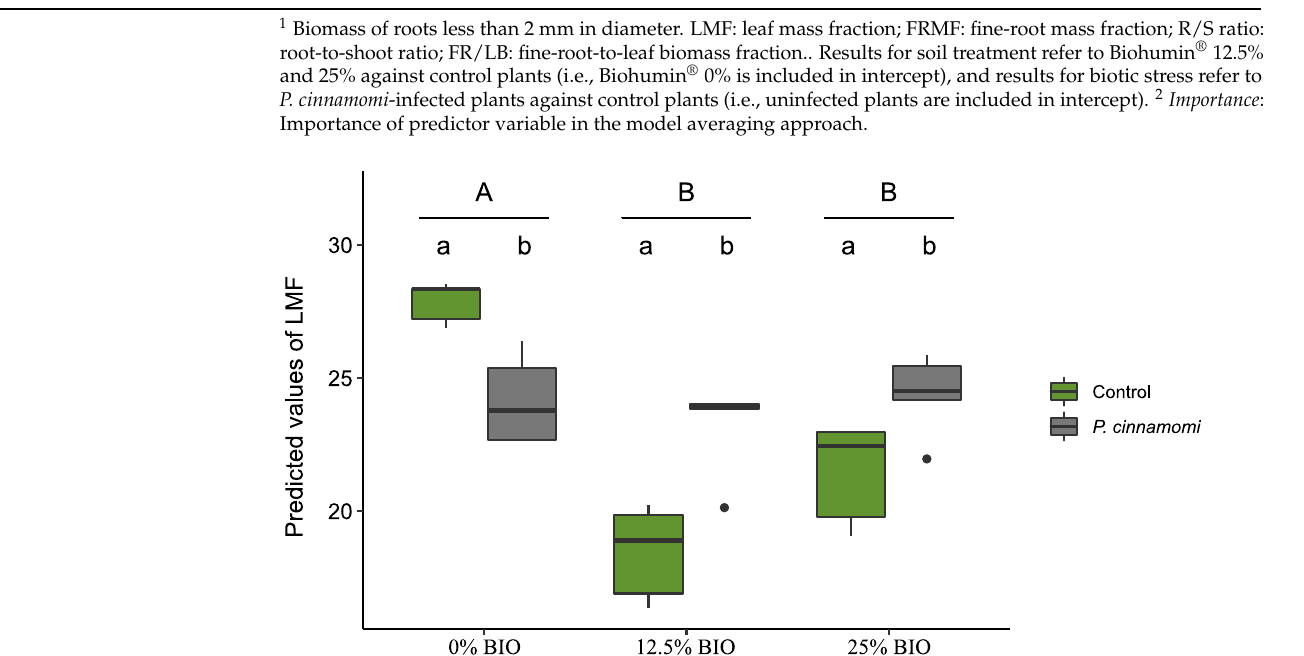
Figure 3. Boxplot of predicted values of leaf mass fraction (leaf dry mass/total plant dry mass; LMF) separated by soil treatments ( x -axis) and P. cinnamomi infection (control plants shown in green colour; infected plants in grey). Lowercase letters indicate differences between P. cinnamomi infection treatments, and capital letters indicate differences among soil treatments.